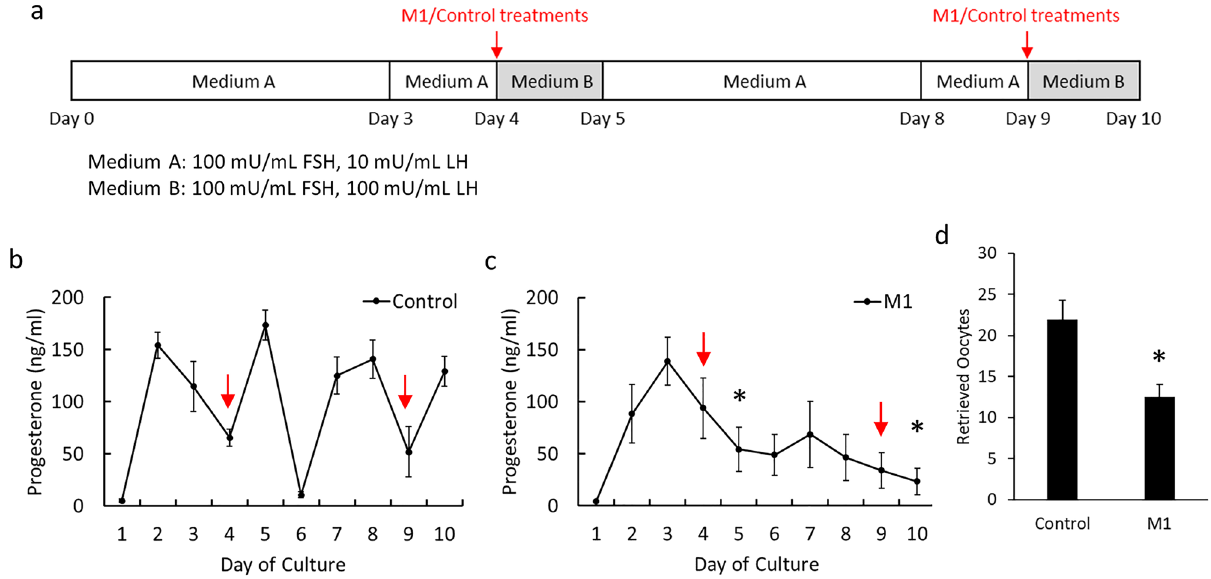
Figure 6. M1 suppressed progesterone secretion and oocyte release during LH stimulation in ovarian organ cultures. The mouse ovaries at proestrus were cultured in the medium containing FSH and LH to mimic the estrus cycle ( a ). The progesterone concentrations in the medium were analyzed in Control ( b ) and M1 groups ( c ). The number of oocytes retrieved from the ovarian culture was also counted ( d ). Values are mean ± SEM (n = 3–4 for each group). *Statistical significance when compared to the control on the same day, P < 0.05, Student’s